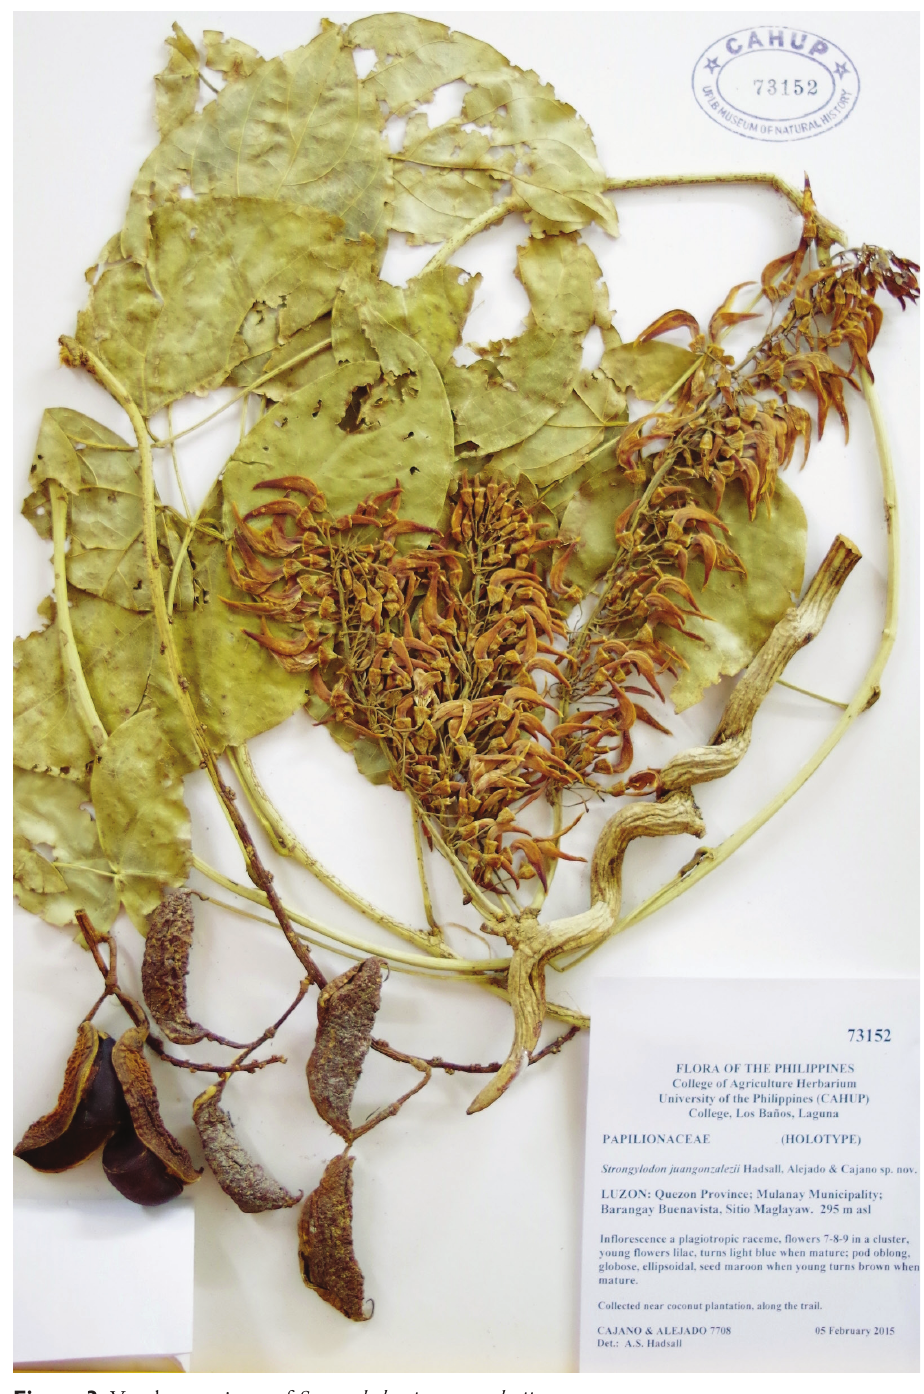
Figure 3. Voucher specimen of Strongylodon juangonzalezii sp.